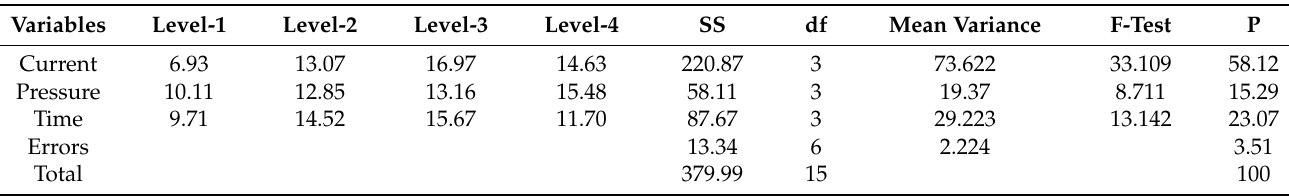
Table 6. ANOVA of the S/N